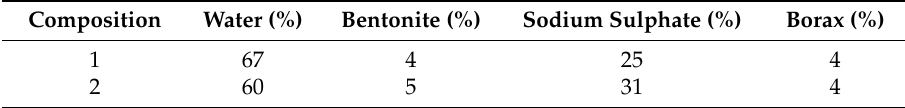
Table 1. Compositional weight percentage of the tested mixtures.